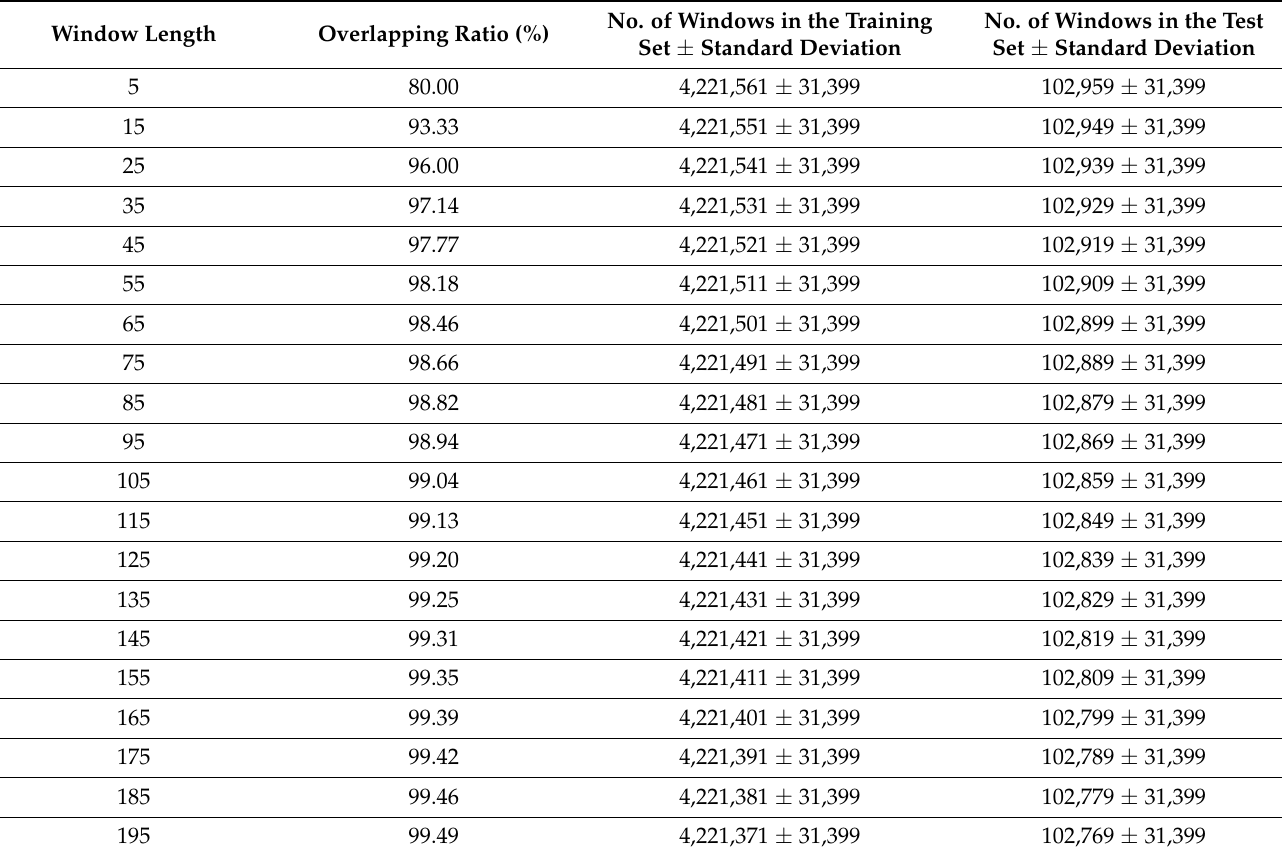
Table 5. The number of windows in the training set and the test set for each window